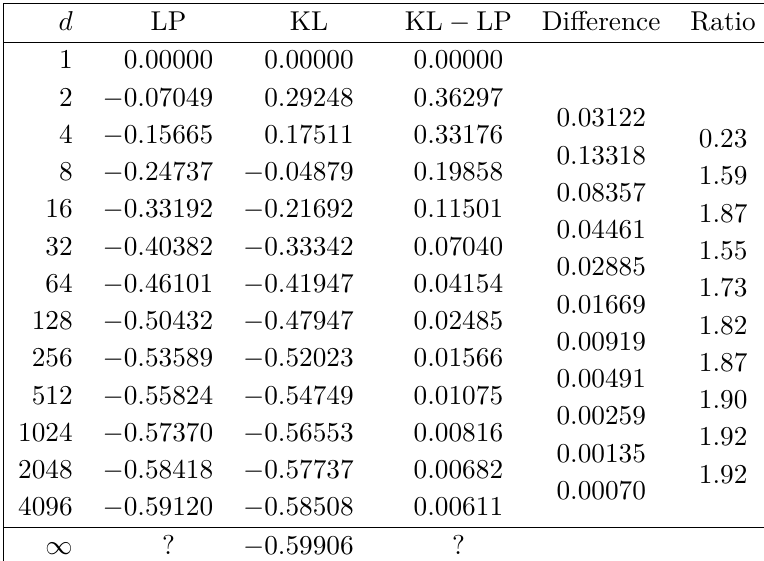
density ) /d , and 2